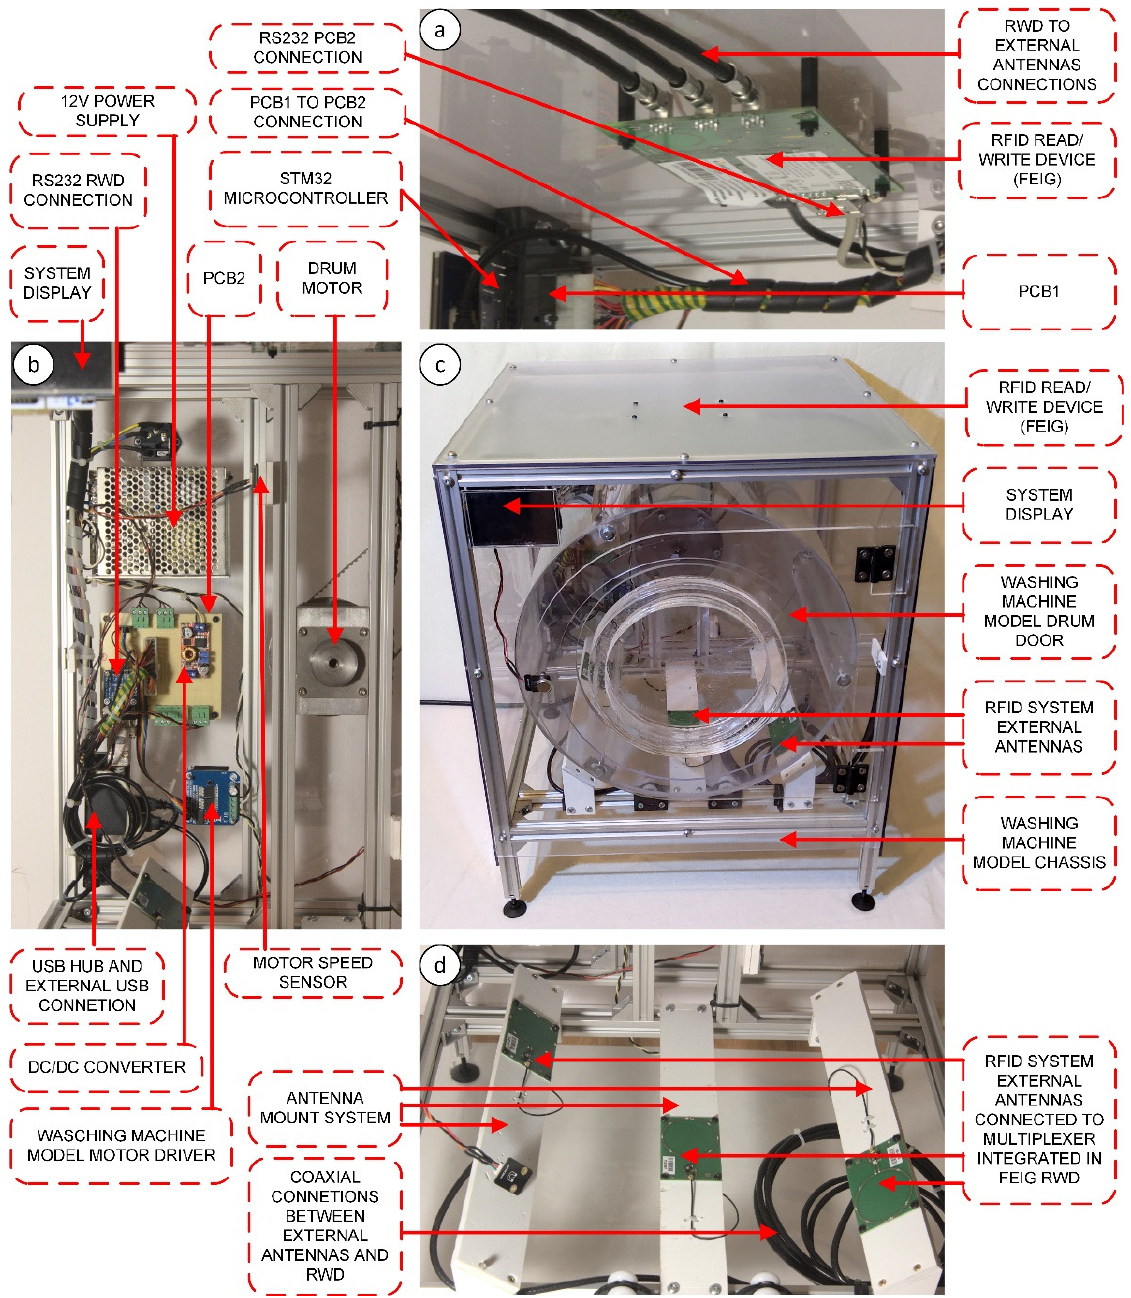
Figure 10. Assembly of electrical and electronic components in the developed model: ( a ) RWD attached to the top cover of the device; ( b ) attachment of the power supply and supporting devices to the rear part of the device housing; ( c ) front view of the device; and ( d ) attachment of the RFID system antennas to the device housing.